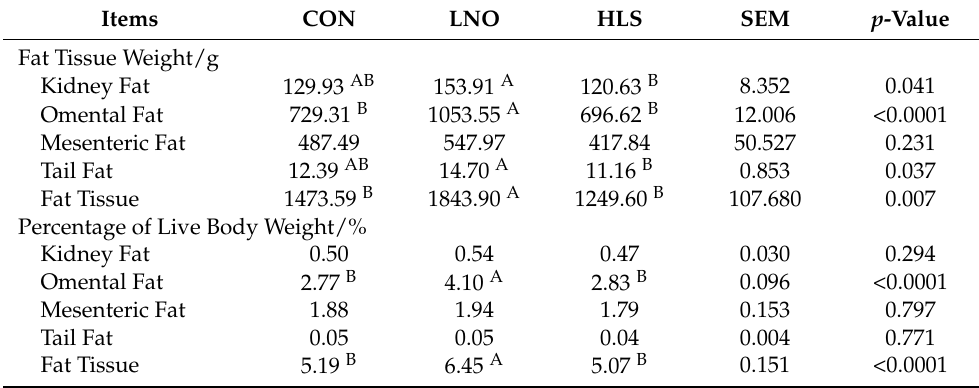
Table 3. The effect of dietary flaxseed oil or flaxseed supplementation on the lipid deposits in Albas cashmere